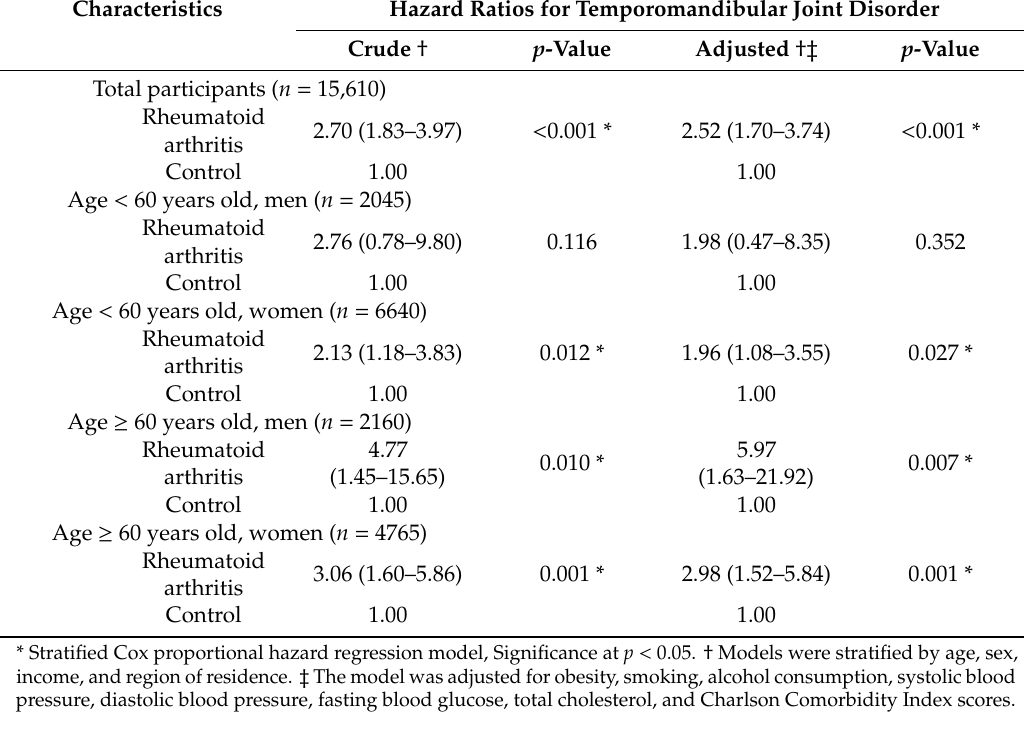
Table 2. Crude and adjusted hazard ratios (95% confidence interval) for temporomandibular joint disorder in the rheumatoid arthritis and control groups.